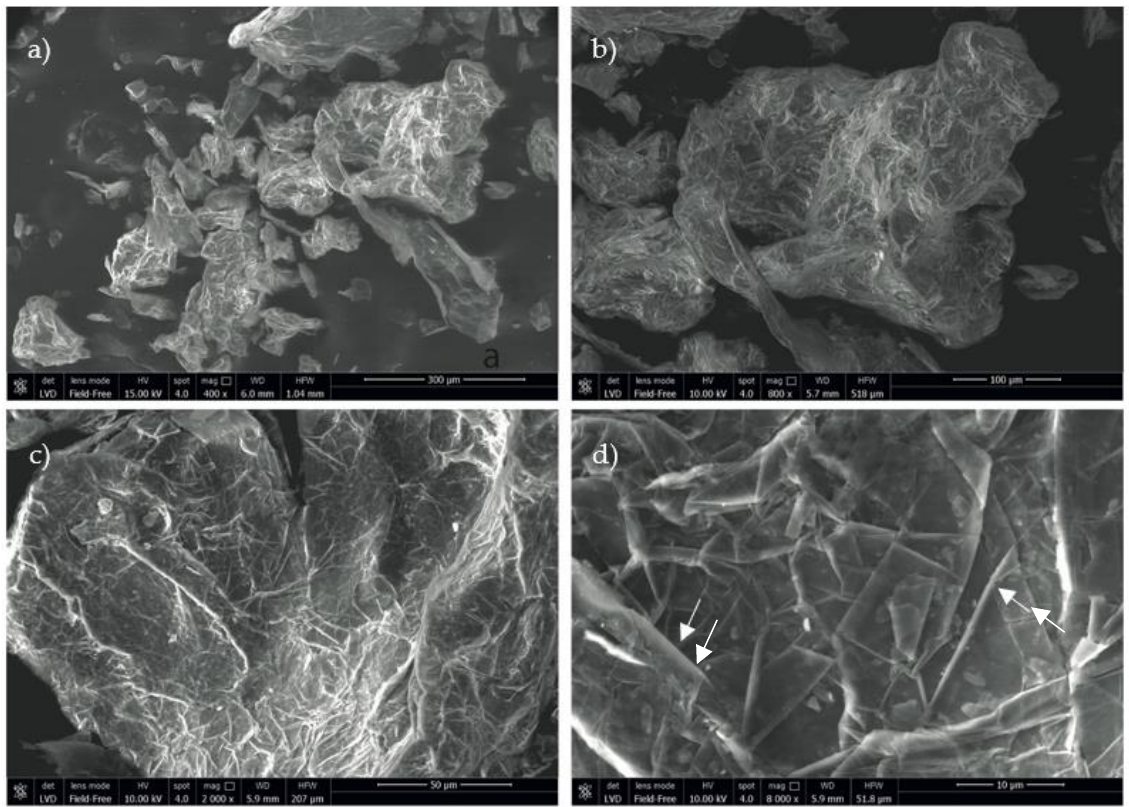
Figure 1. SEM images of industrial fluorographene at different magnifications: ( a ) 400 × ; ( b ) 800 × ; ( c ) 2000 × ; ( d ) 8000 × . Typical fluorographene morphology showing a multilayered structure and characterizing grain morphology at higher magnifications (white arrows in ( d )). Table 1. Compositions of the materials used in this study. Fluorographene was added to